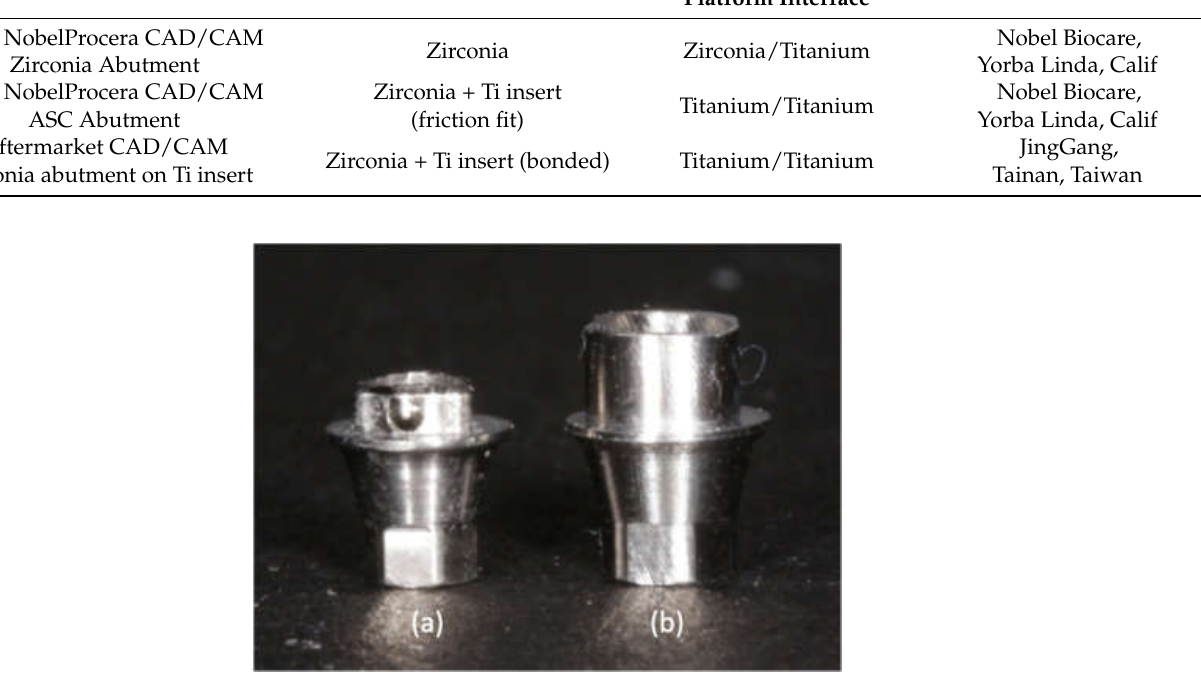
Figure 1. Titanium insert of NobelProcera ASC abutment ( a ) and aftermarket abutments ( b ).